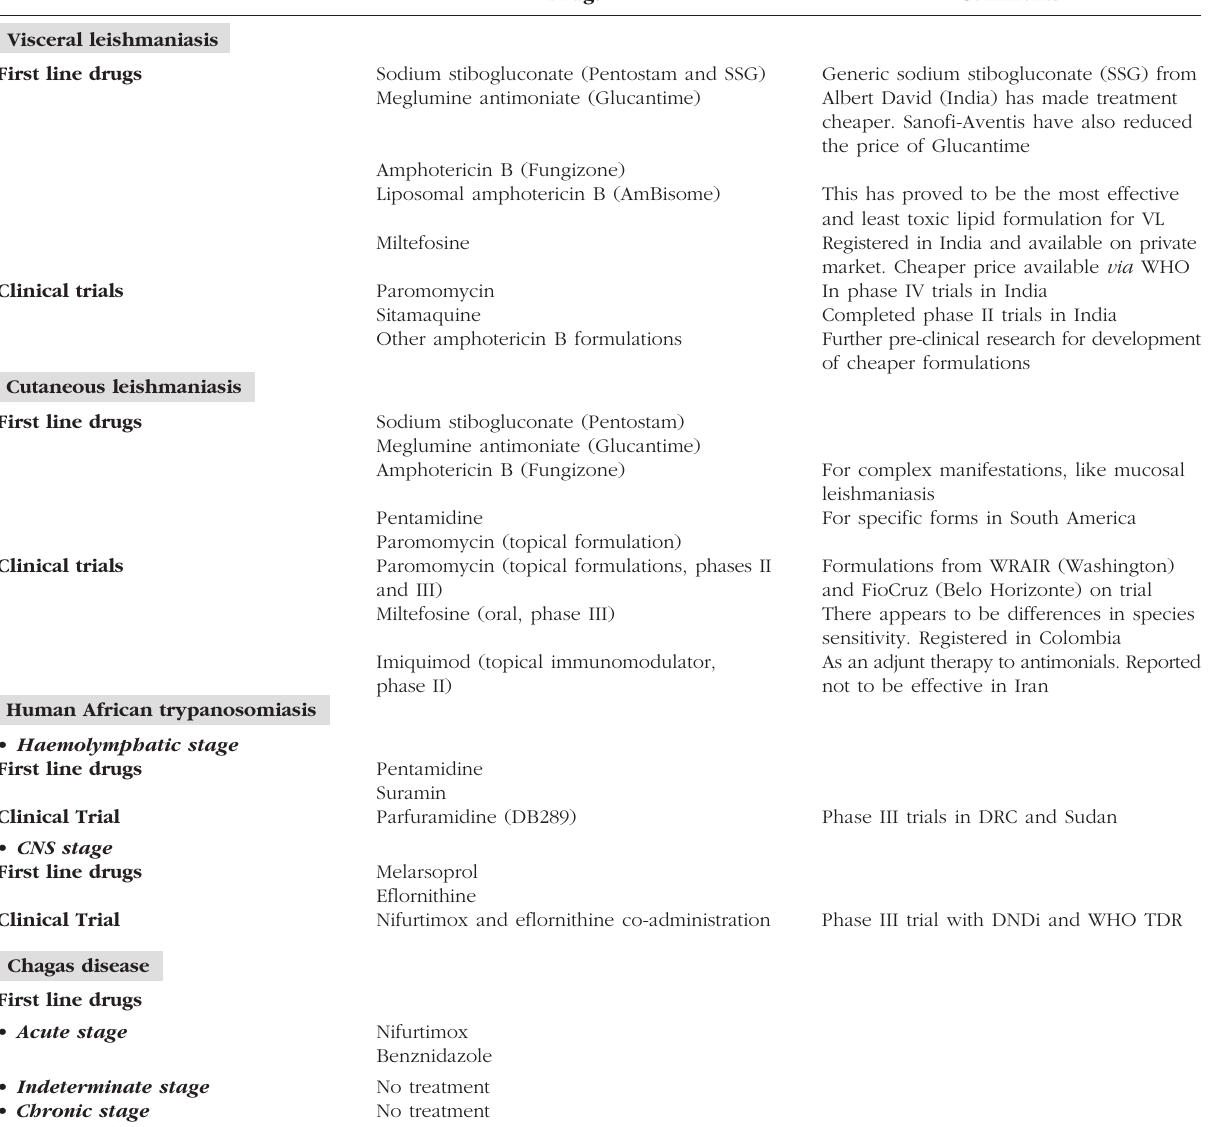
Table I. - Drugs in use or on clinical trial in